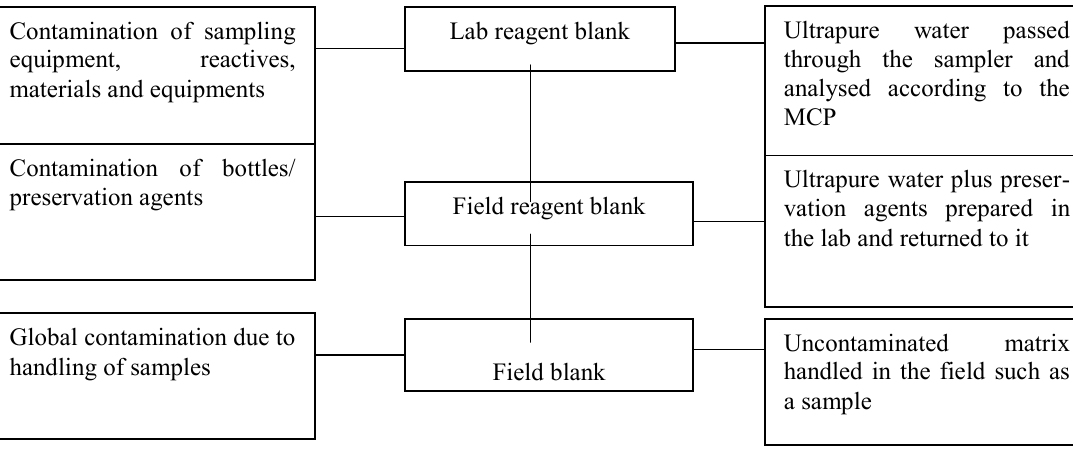
FIGURE 1. Types of blanks used in the analysis of organic traces in water samples